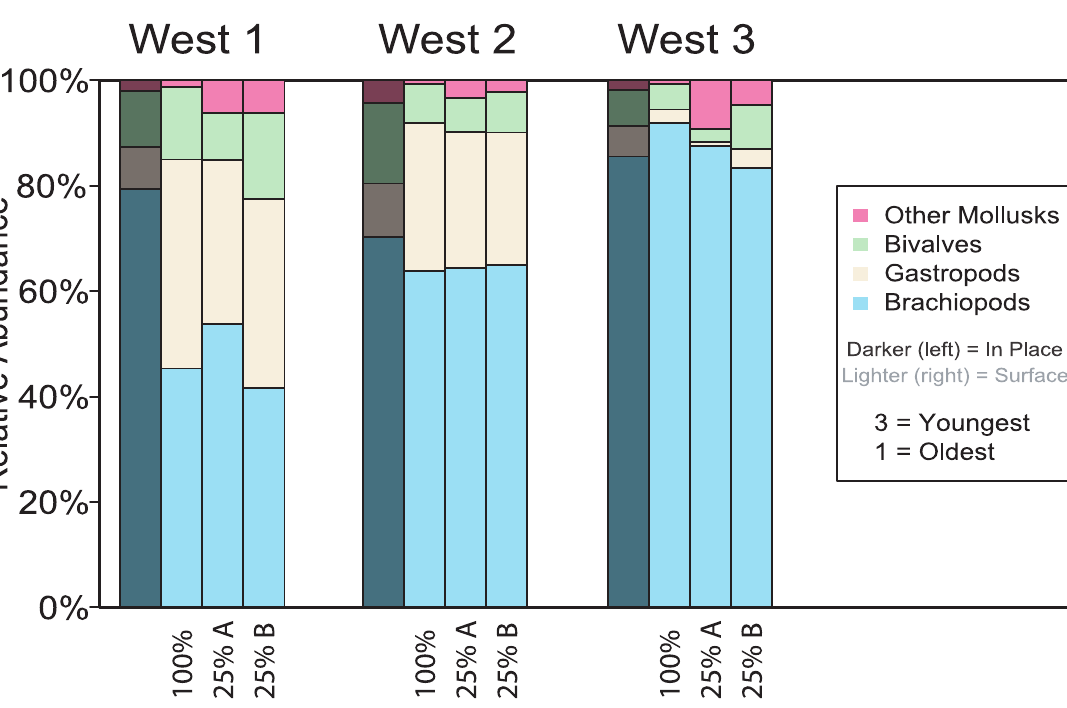
Fig 8. Relative abundance of major taxonomic groups. Relative abundance of major taxonomic groups in the three Spillway West samples, compared between the in-place sample, the 100% surface sample, and the two 25% subsamples (A and B). The lower the number, the lower stratigraphic